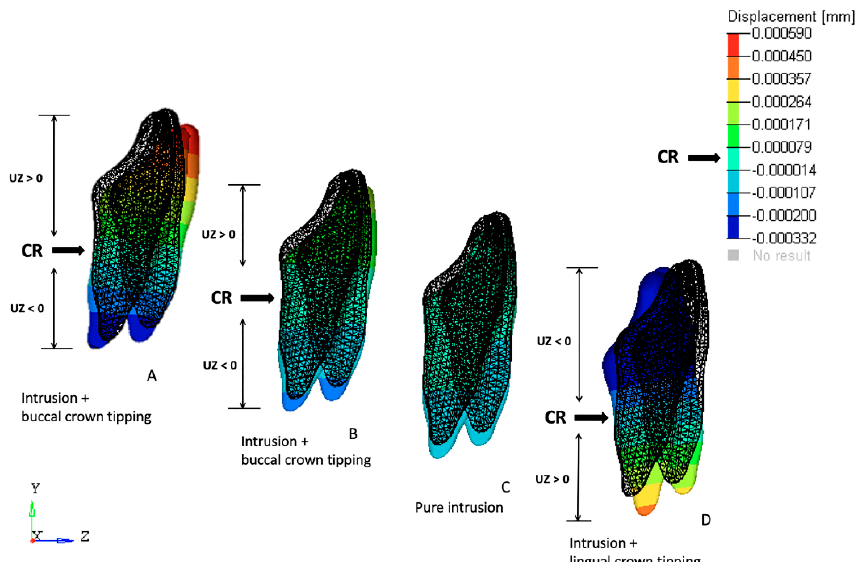
Figure 4. Initial displacement tendency of the mandibular incisors under 40 g of intrusive force in a sagittal view. Teeth displacement was magnified 500 times. Initial position (drawn) and final position (color). ( A ) FEM 1, ( B ) FEM 2, ( C ) FEM 3, and ( D ) FEM 4.